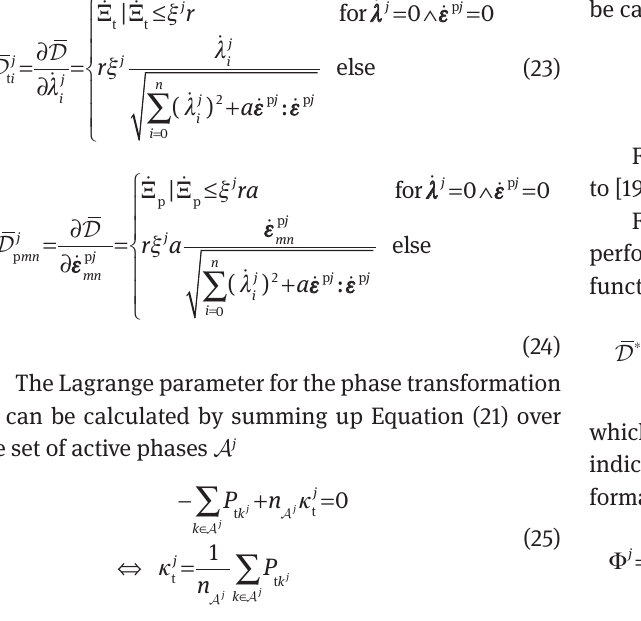
where, due to their definitions in (18) and (23), the sum over the subdifferential and the parameter j denotes the number of active